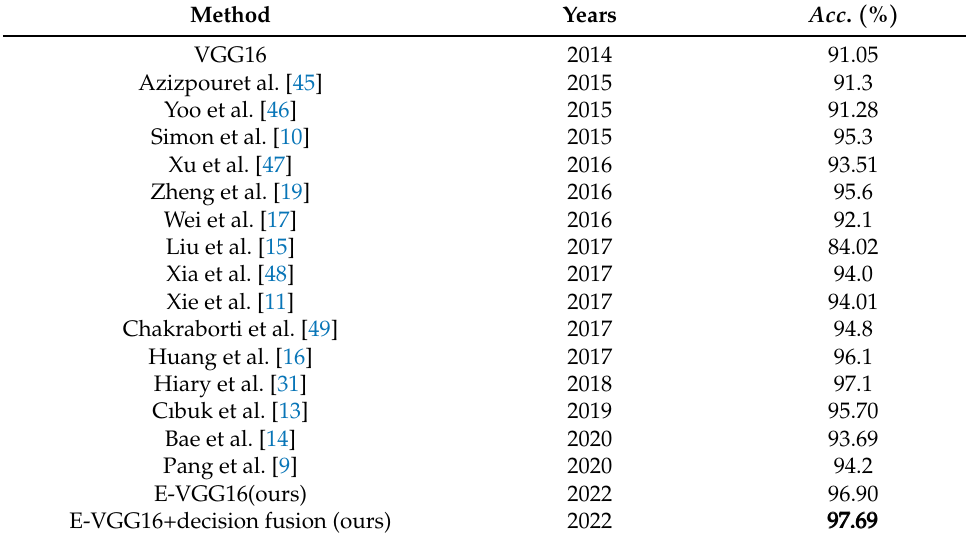
Table 5. Comparisons with the state-of-the-art methods on Oxford